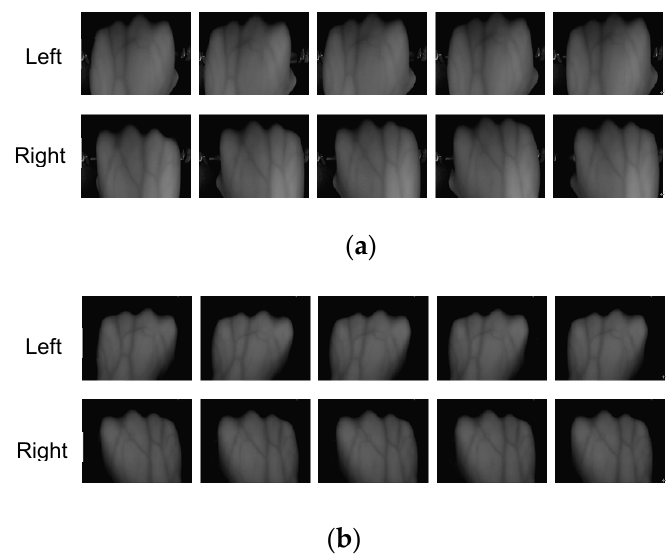
Figure 2. Dorsal hand vein images captured by two different devices. ( a ) Captured by No. 1 device; ( b ) captured by No. 2 device.